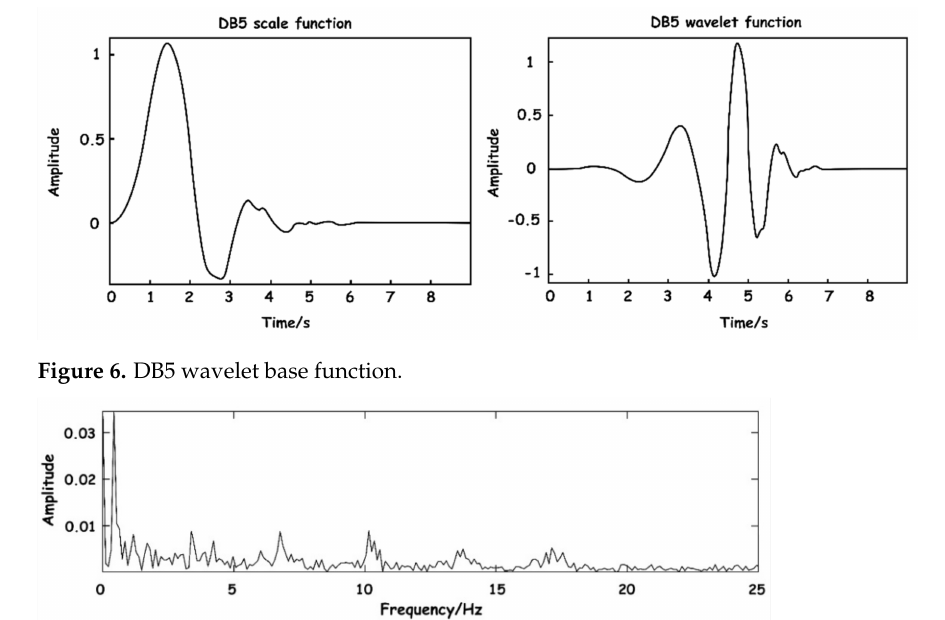
Figure 7. Spectrum diagram of the original signal.